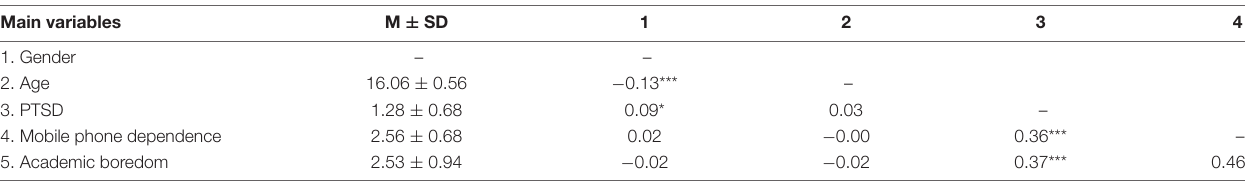
TABLE 1 | Means, standard deviations, and correlations among main variables. Main